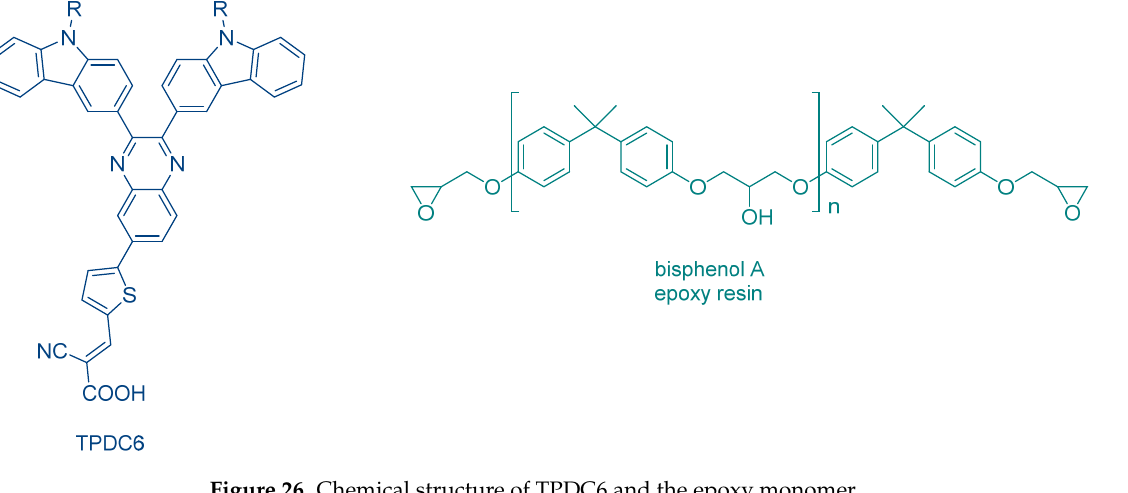
Figure 26. Chemical structure of TPDC6 and the epoxy monomer.